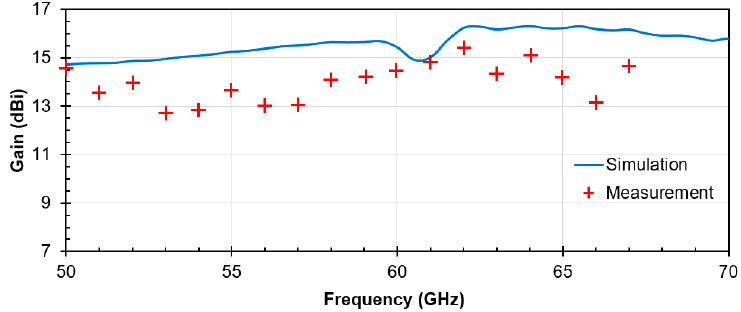
Figure 6. Simulated (solid line, blue) and de-embedded measured gain (crosses, red) of the presented LWA in dBi plotted over the radio frequency.